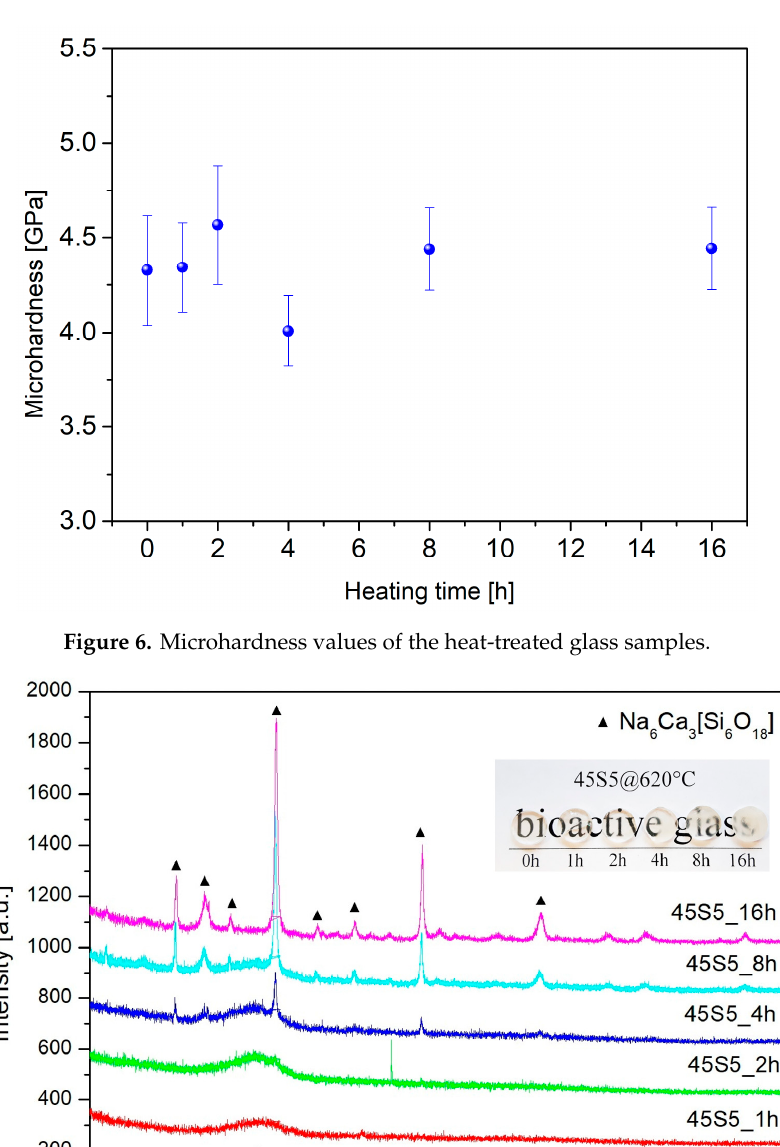
Figure 6. Microhardness values of the heat-treated glass samples.